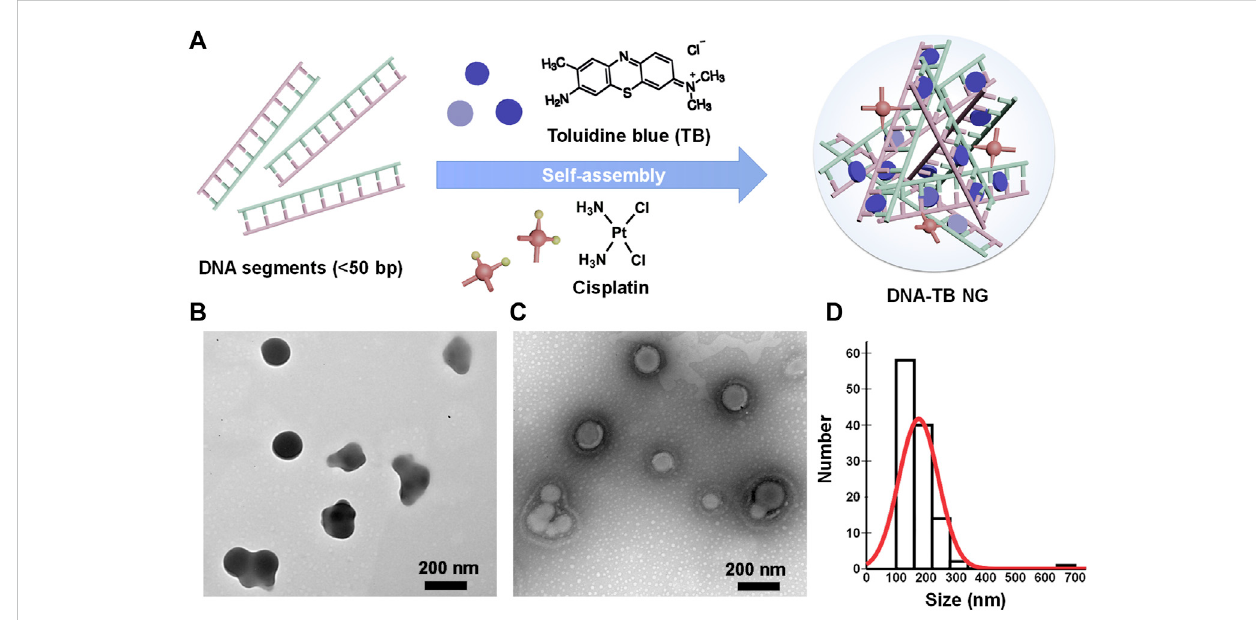
FIGURE 1 Preparation of DNA/TB NG. (A) Schematic illustration of the self-assembly of DNA/TB NG. (B) Representative TEM image (no staining). (C) Representative TEM image of the DNA/TB NG with negative staining. (D) Size distribution of DNA/TB NG calculated from TEM (with